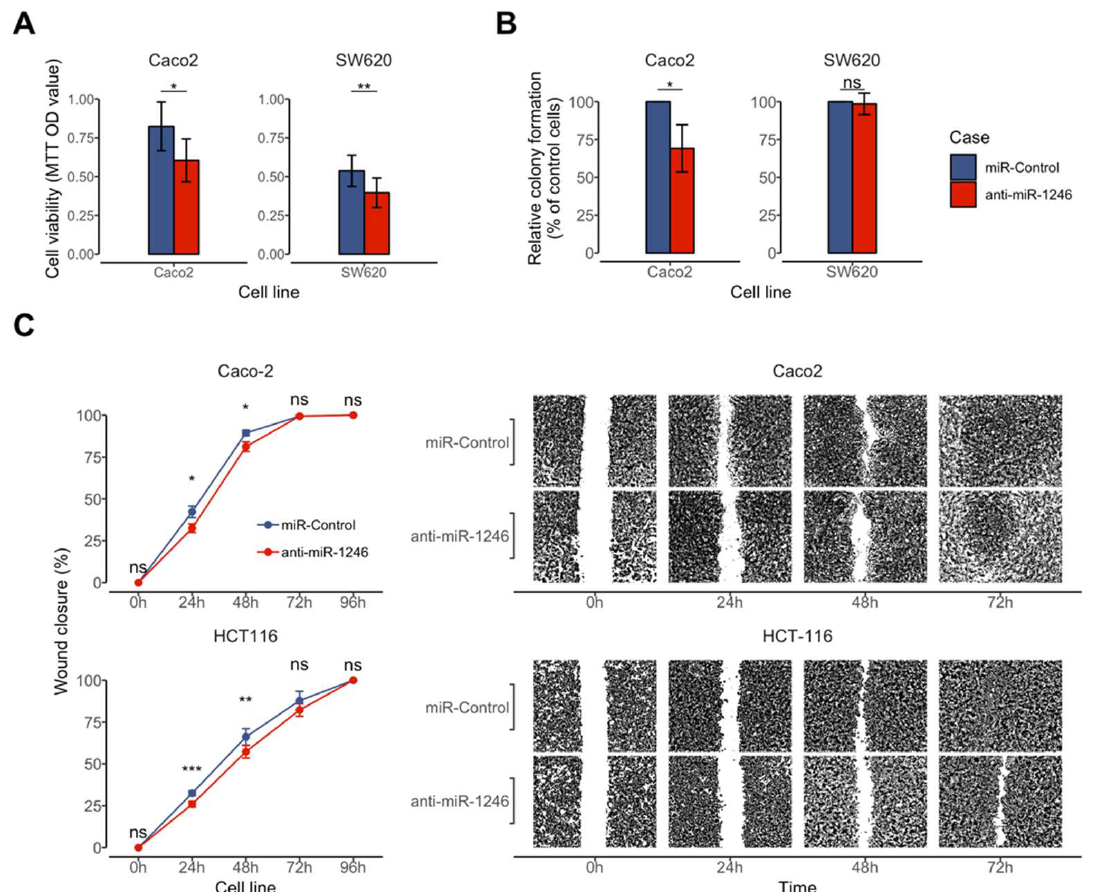
Figure 2. Effect of hsa-miR-1246 inhibition on cell viability, colony formation, and migration of Caco-2, HCT116, and SW620 cells. Inhibitor anti-miR-1246: ( A ) reduced cell viability in Caco-2 and SW620 cells; ( B ) reduced colony formation ability in Caco-2 cells; ( C ) lowered cell migration rates in Caco-2 and HCT116 cells 24 h and 48 h after transfection. Image magnification is × 20. Data are presented as the mean ± standard deviation (SD) of three independent experiments. Significance levels: * P FDR < 0.05; ** P FDR < 0.01; *** P FDR < 0.001; ns—not significant. Since wounds were fully closed after 96 h, images representing this time point were not included in the figure.